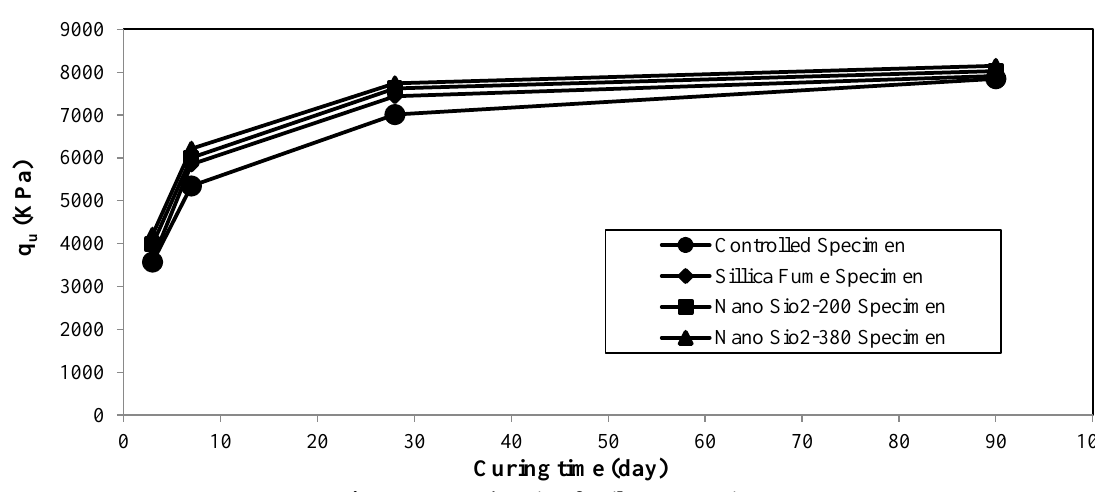
Fig. 10. Strength gain of soil-cement